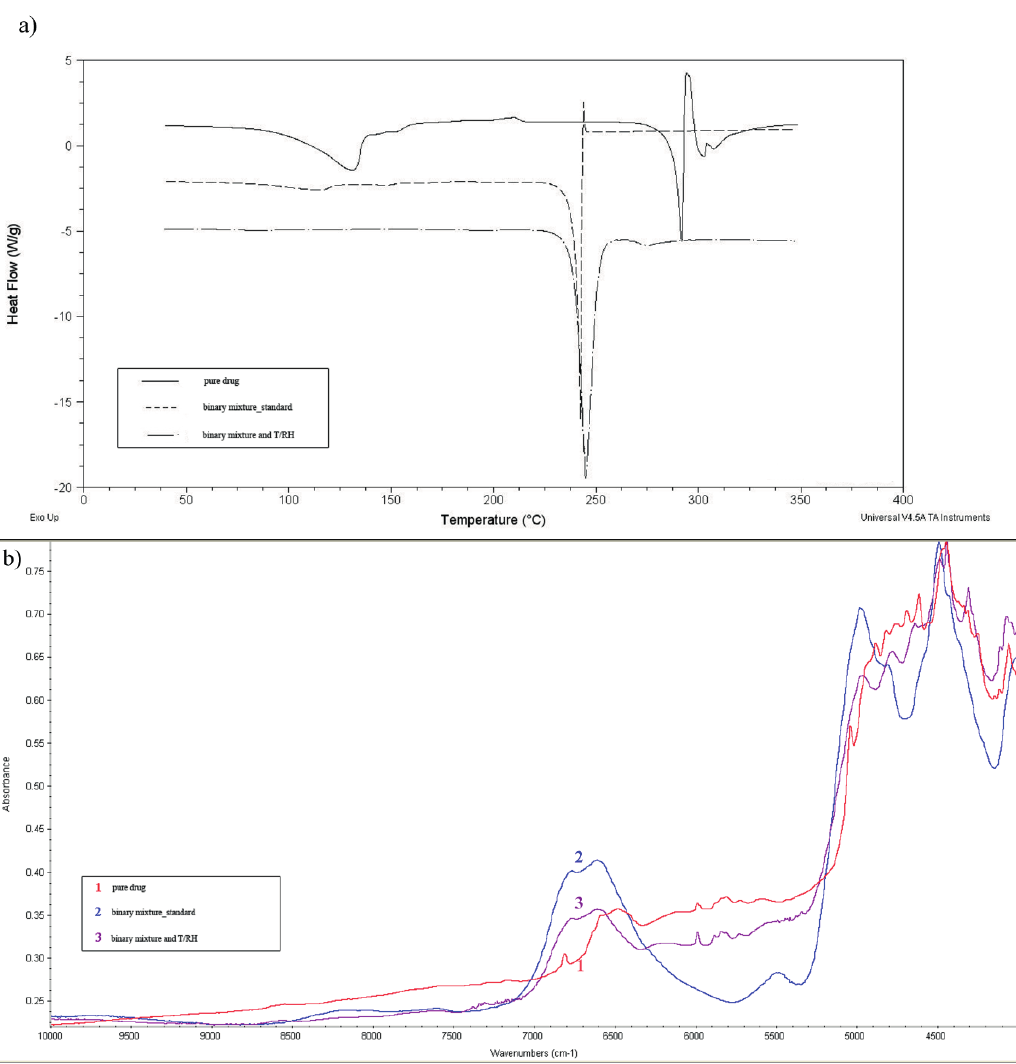
Figure 7 : Amiloride and glycine: DSC scans (a) and NIR spectra (b) for the mixture stressed with high temperature/humidity (T/RH) and the untreated mixture (standard) against pure